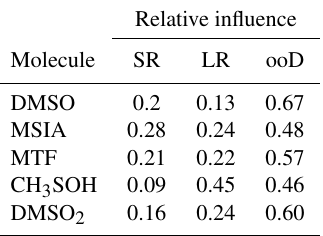
Table 3. Relative influence of short-range transport of local emis- sions (SR, < 100km), long-range transport within the FLEXPART domain (LR, > 100km), and from sources outside of the domain (ooD, influx through lateral boundaries, > 1600km, free tropo- spheric